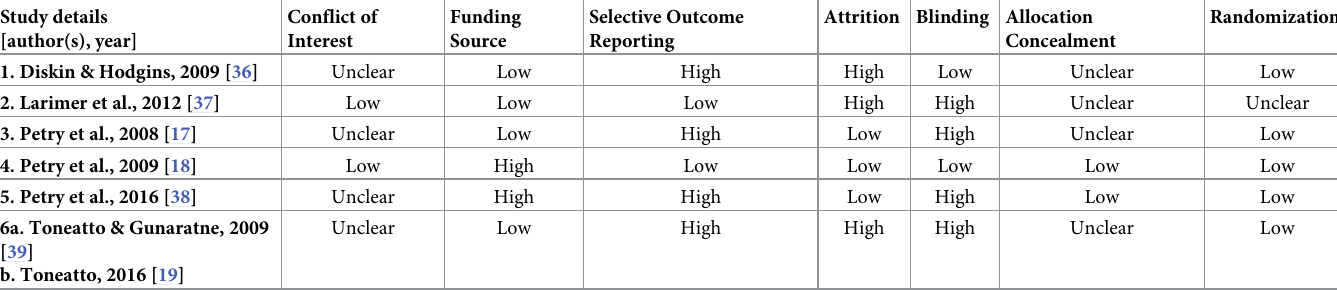
Table 3. Estimated potential risk of Bias.